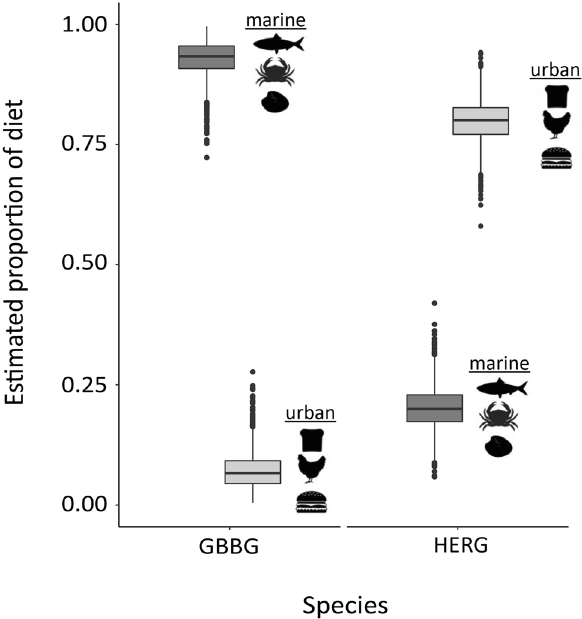
Figure 4. Estimated proportions of urban food (light grey) and marine prey (dark grey) in the diets of great black-backed gulls and herring gulls, respectively. Diet proportions were estimated using Bayesian isotopic mixing model (MixSIAR 26 ) using δ 15 N and δ 13 C values of gull whole blood and gull diet-based urban food (bread, fast-food meat) and marine food (bivalves, crabs, fish)